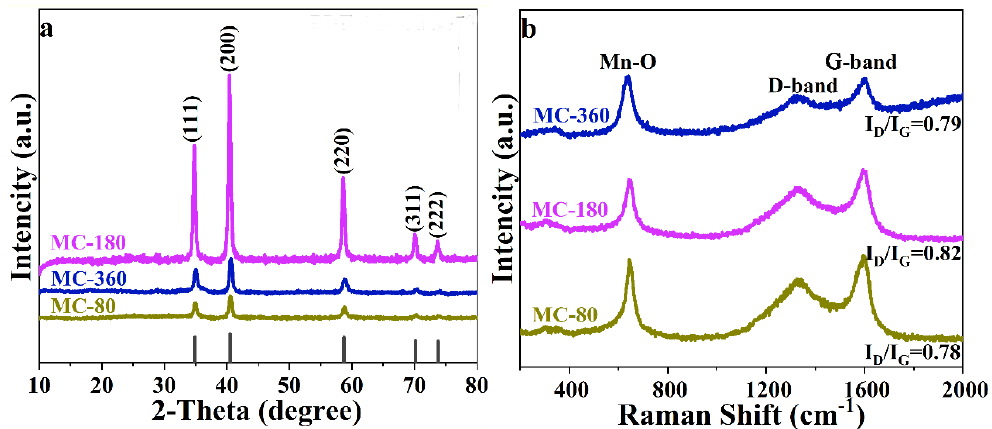
Figure 2. ( a ) XRD patterns and ( b ) Raman spectra of MC-80, MC-180, and MC-360.